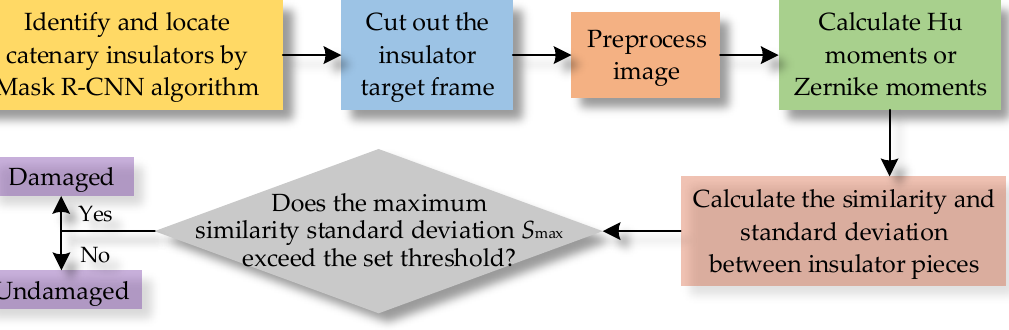
Figure 8. The process of catenary insulator damage detection.